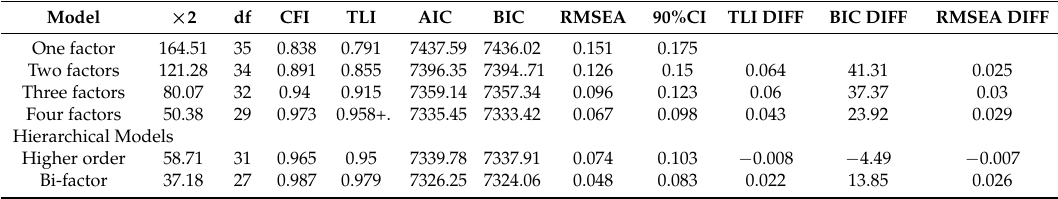
Table 2. Confirmatory Factor Analysis Fit Statistics for WAIS –IV.